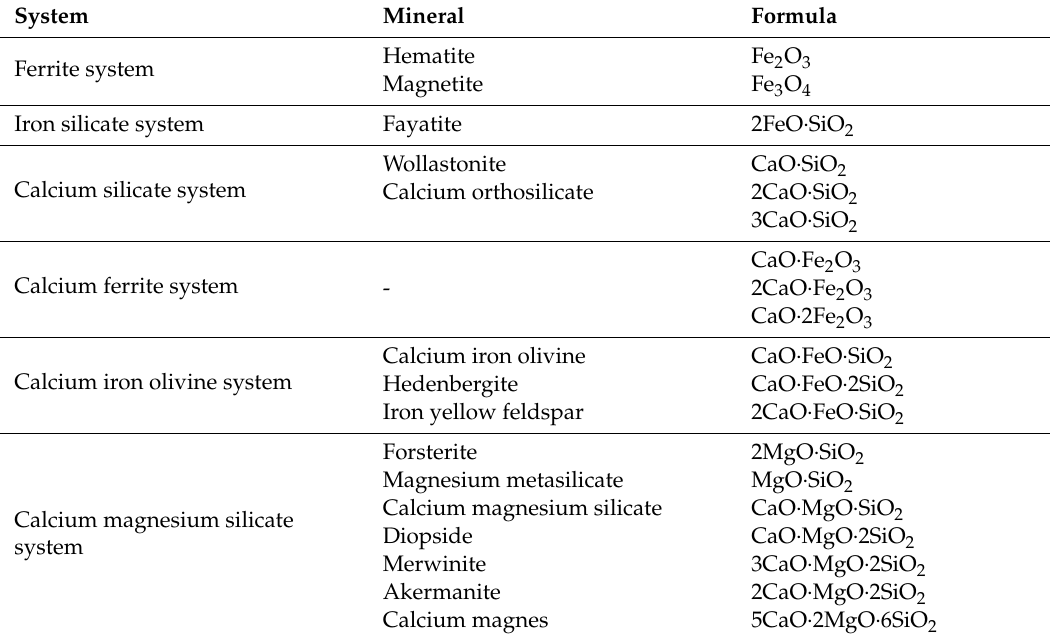
Table 5. Main minerals of sinter ore